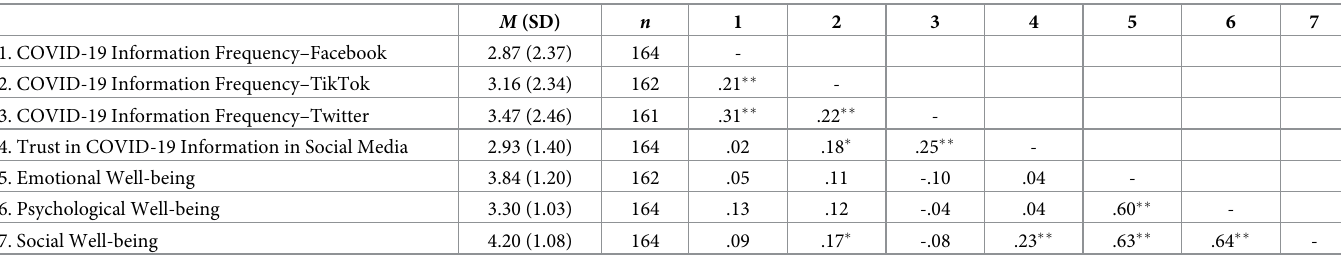
Table 1. Means, sample sizes, and zero-order correlations for key study variables.